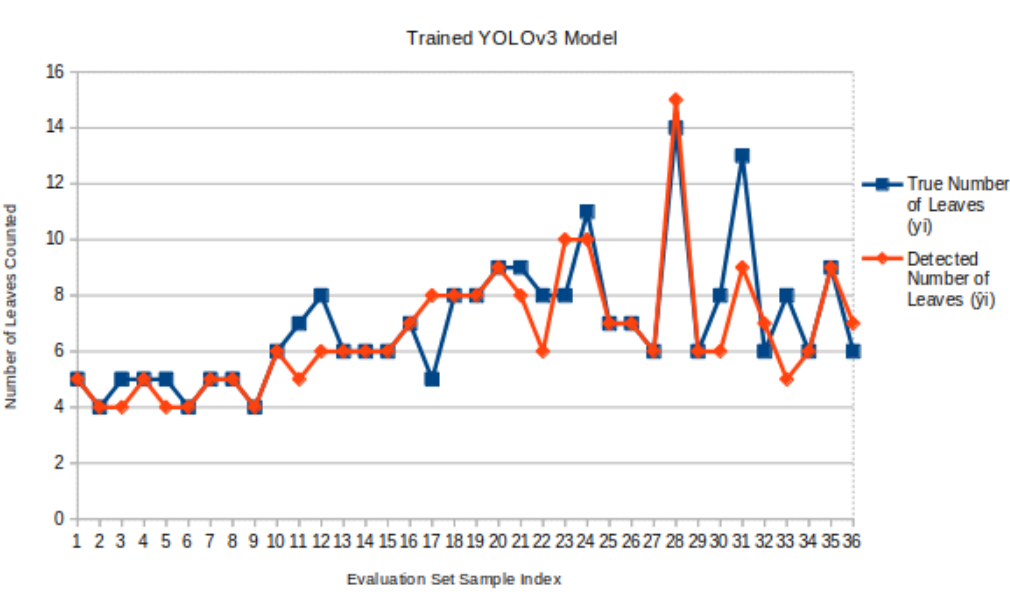
Figure 7. Scatter plot comparison between true leaf count vs. estimated leaf count from YOLO